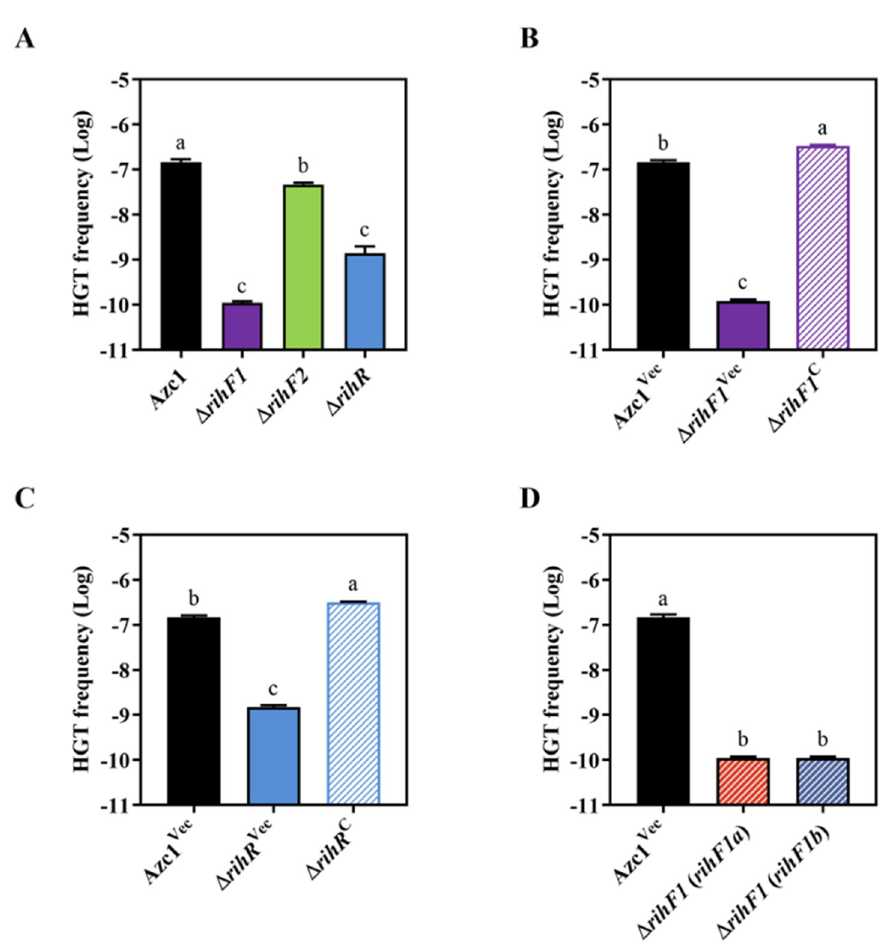
Figure 3. Identification transfer capacities of ICE Ac in different rgf4 gene deletion strains. ( A ) The transfer frequency of ICE Ac in strains ∆ rihF1 , ∆ rihF2 , and ∆ rihR . ( B ) The transfer frequency of ICE Ac in ∆ rihF1 Vec and ∆ rihF1 C . ( C ) The transfer frequency of ICE Ac in ∆ rihR Vec and ∆ rihR C . ( D ) The transfer frequency of ICE Ac in ∆ rihF1 ( rihF1a ) and ∆ rihF1 ( rihF1b ). The strains were mixed with M. huakuii 93, and the CFU of the transconjugants was determined. Data are mean ± SD of three independent experiments. Means not connected by the same letter are significantly different ( p < 0.05). The same letter indicates no significant difference ( p > 0.05).